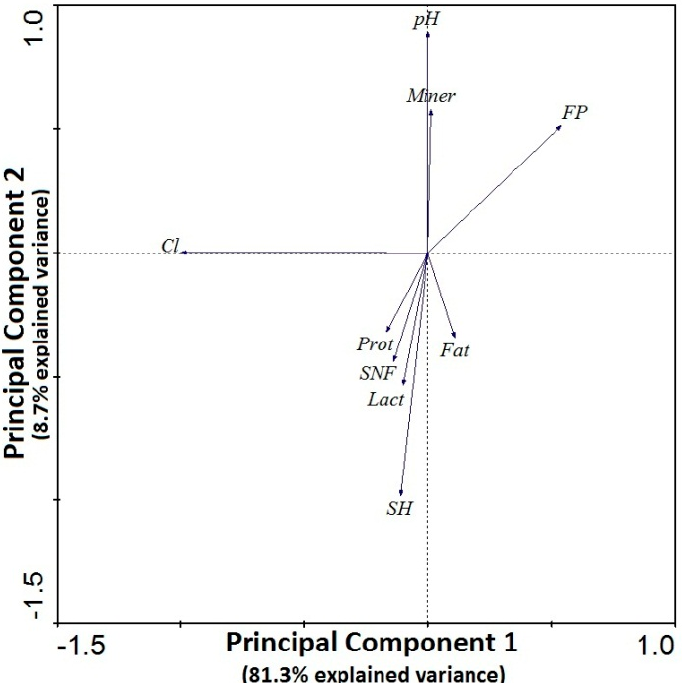
Figure 2. Principal component analysis (PCA) biplot of the relationships between chlorides in the milk and other selected chemical and physical characteristics of raw cow’s milk from 10 samples (80 variants) with the added NaCl (evaluated similarly to Figure 1).